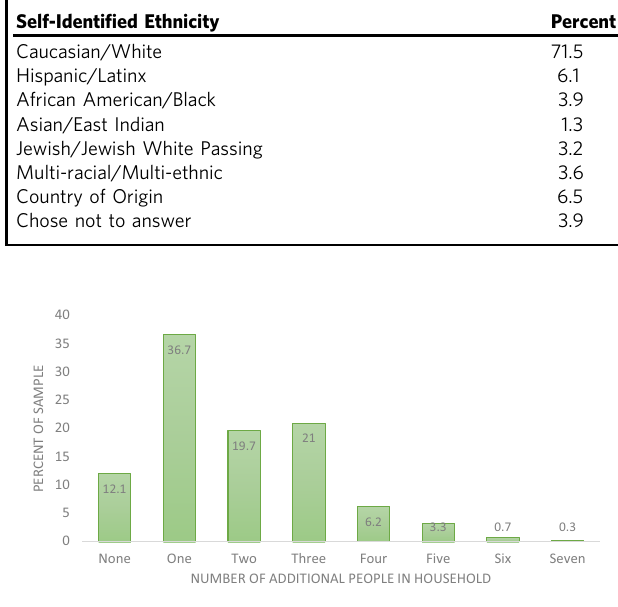
Fig. 1 Number of additional people in household as a percent. Figure shows how many additional individuals live in the participant ’ s household in